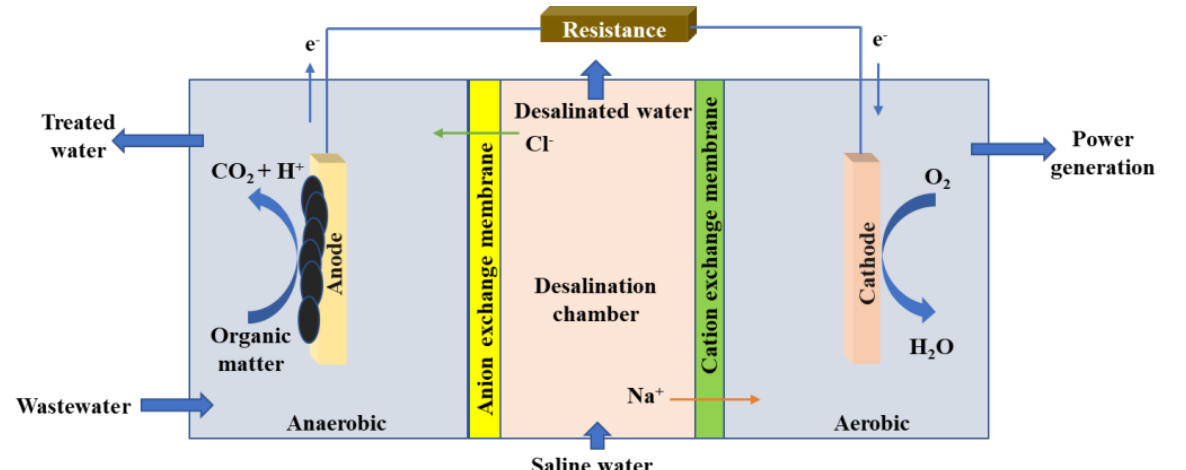
Figure 3. A schematic diagram of a microbial desalinization cell.